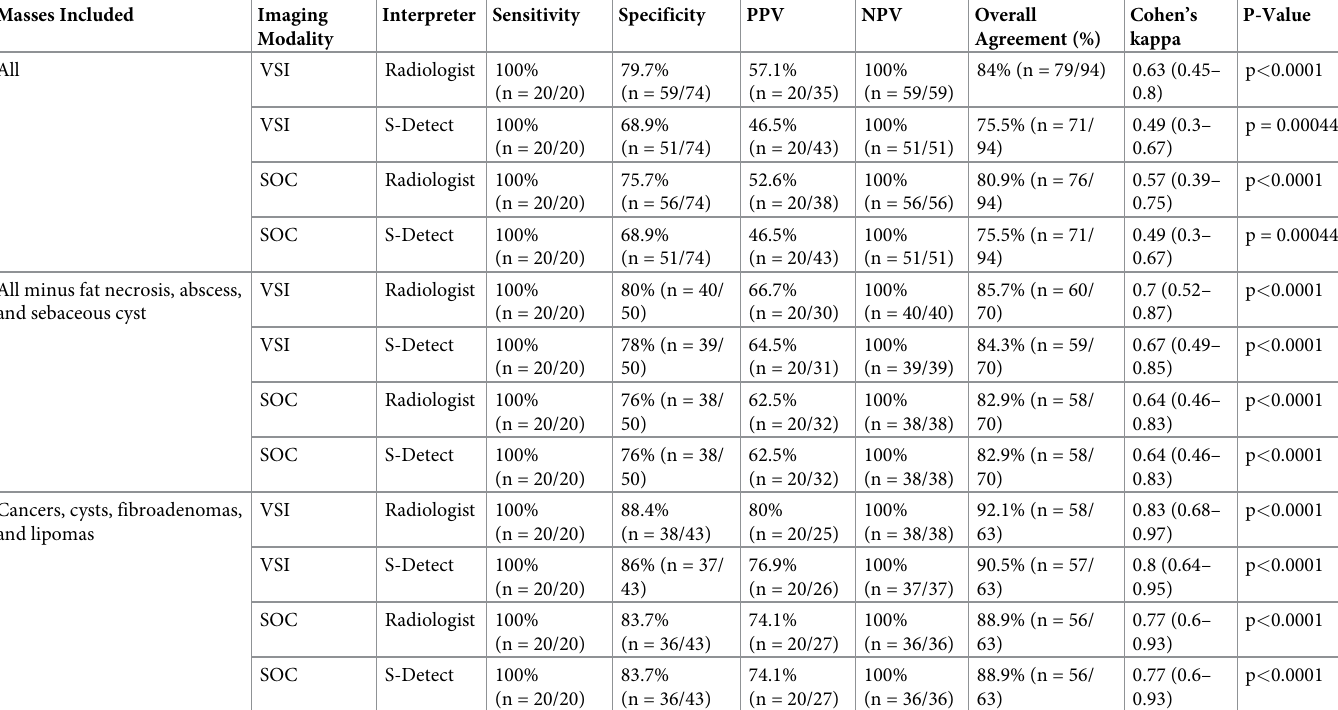
Table 3. Sensitivity and specificity for masses based on pathological diagnosis. SOC = standard of care. Masses